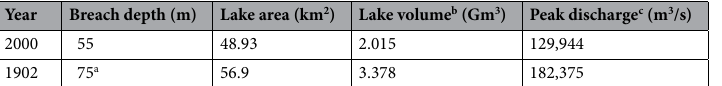
3.424 ∗ 3304.5 15 , where A is the area of impounded water. c Peak 0.41 23 , where H is the barrier lake water depth and V is the lake